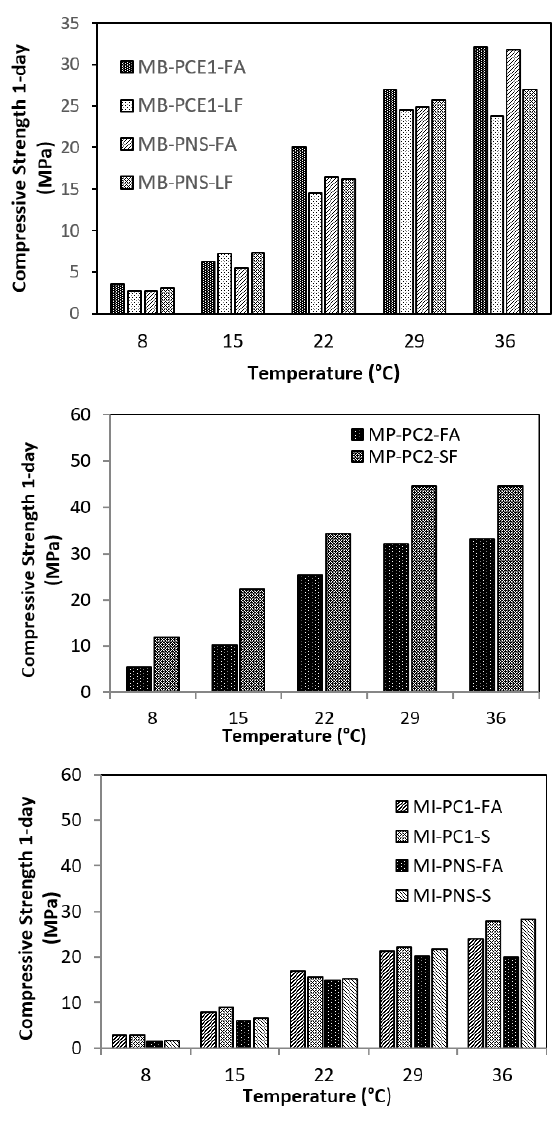
Figure 2. Compressive strength of CEM mixtures at different temperatures at 1